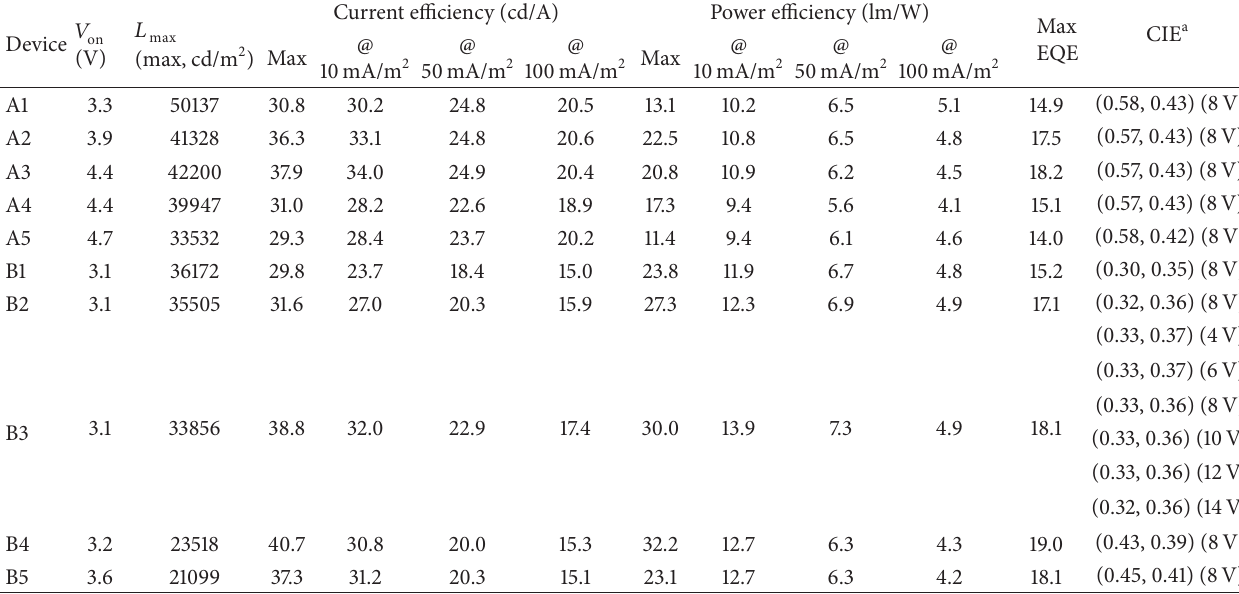
Table 1: Representative data of devices in this